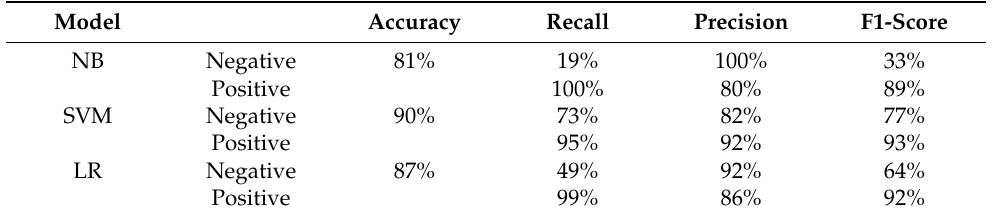
Table 4. Performance metrics of MLSA with hold out method.